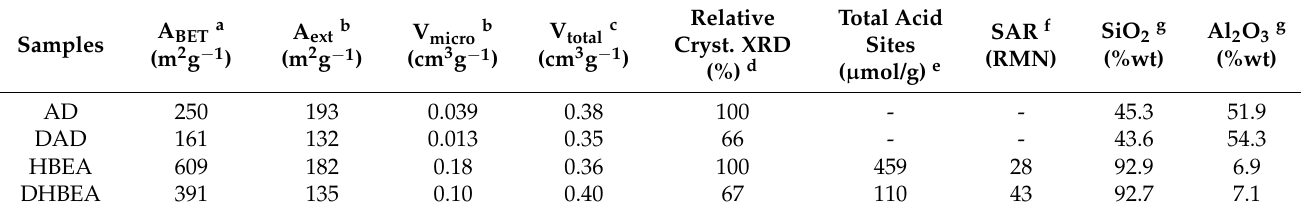
Table 2. Structural and textural properties of beta zeolite and beta catalyst.